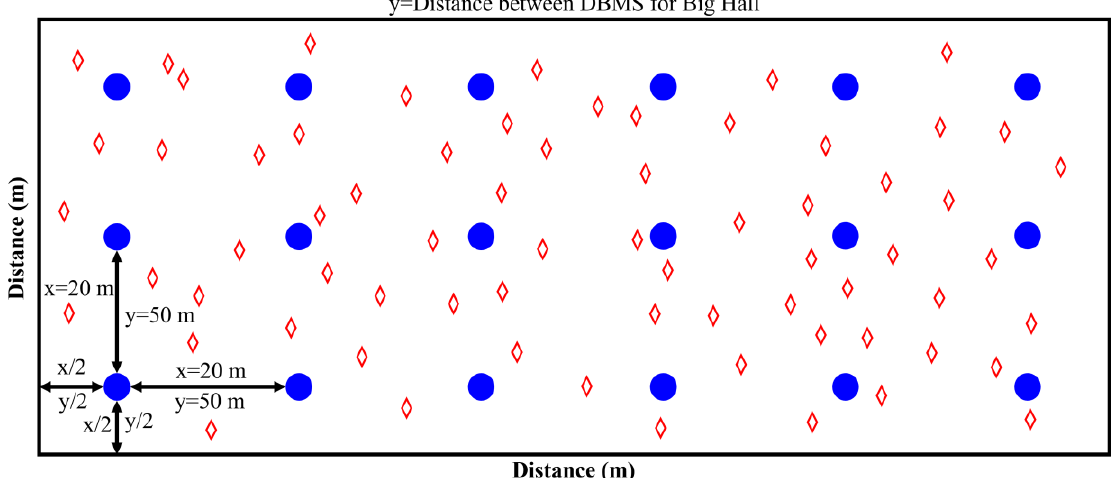
Figure 2. Simulation scenario in MATLAB; InF: Red diamond = UE, Blue circle = Dual-Mode Base Stations.